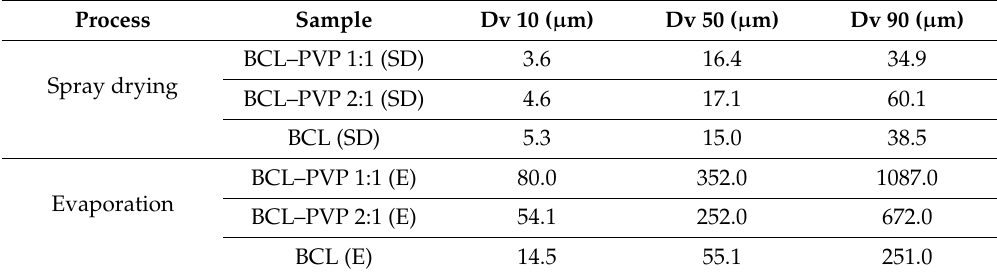
Table 2. Particle size distribution results obtained using the laser diffraction method.